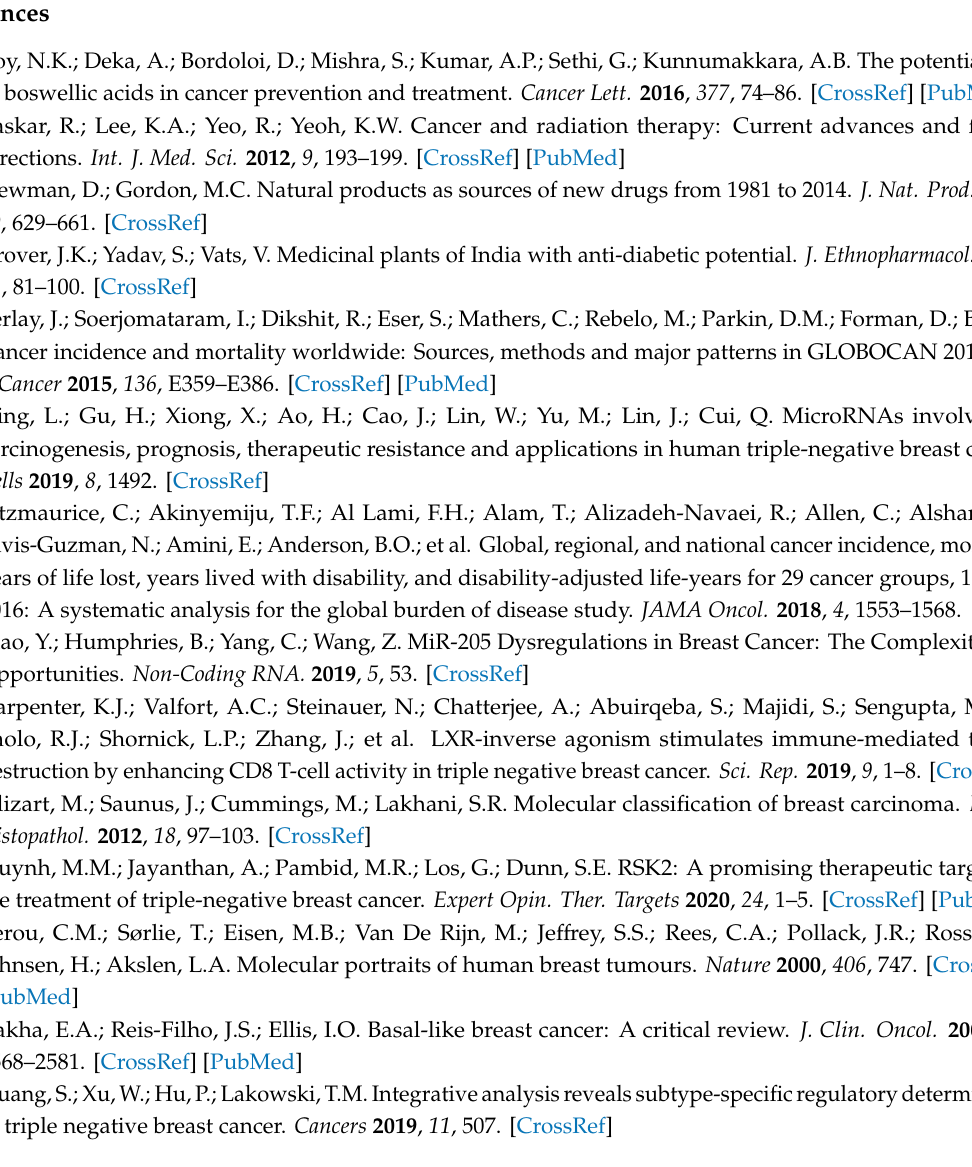
Table S1: Human intra-cellular targets—swiss target prediction results. Table S2: Molecular docking scores and binding interactions of compounds 1 – 3 , 5 , 7 , and 12 on the selected drug targets. Figure S1: 1 H, 13 C-NMR and ESI-MS spectra of the known compounds ( 1 – 20